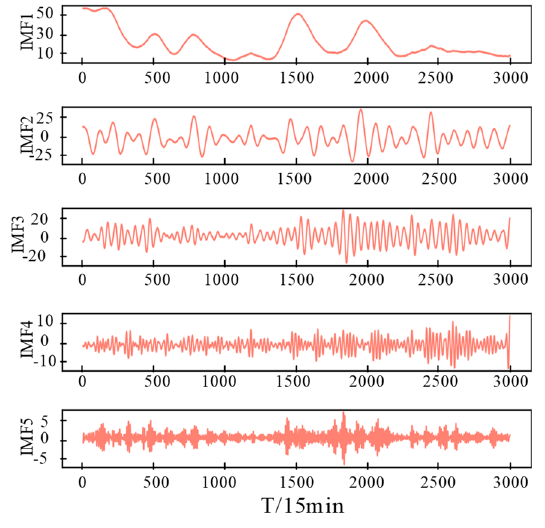
Figure 6. Decomposed sub–sequence of wind power by VMD.